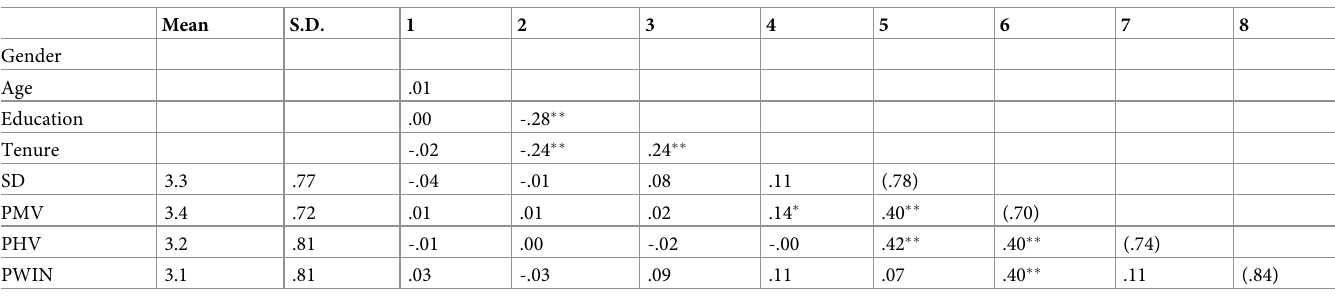
Table 3. Descriptive statistical analysis, reliability analysis, and correlation coefficient